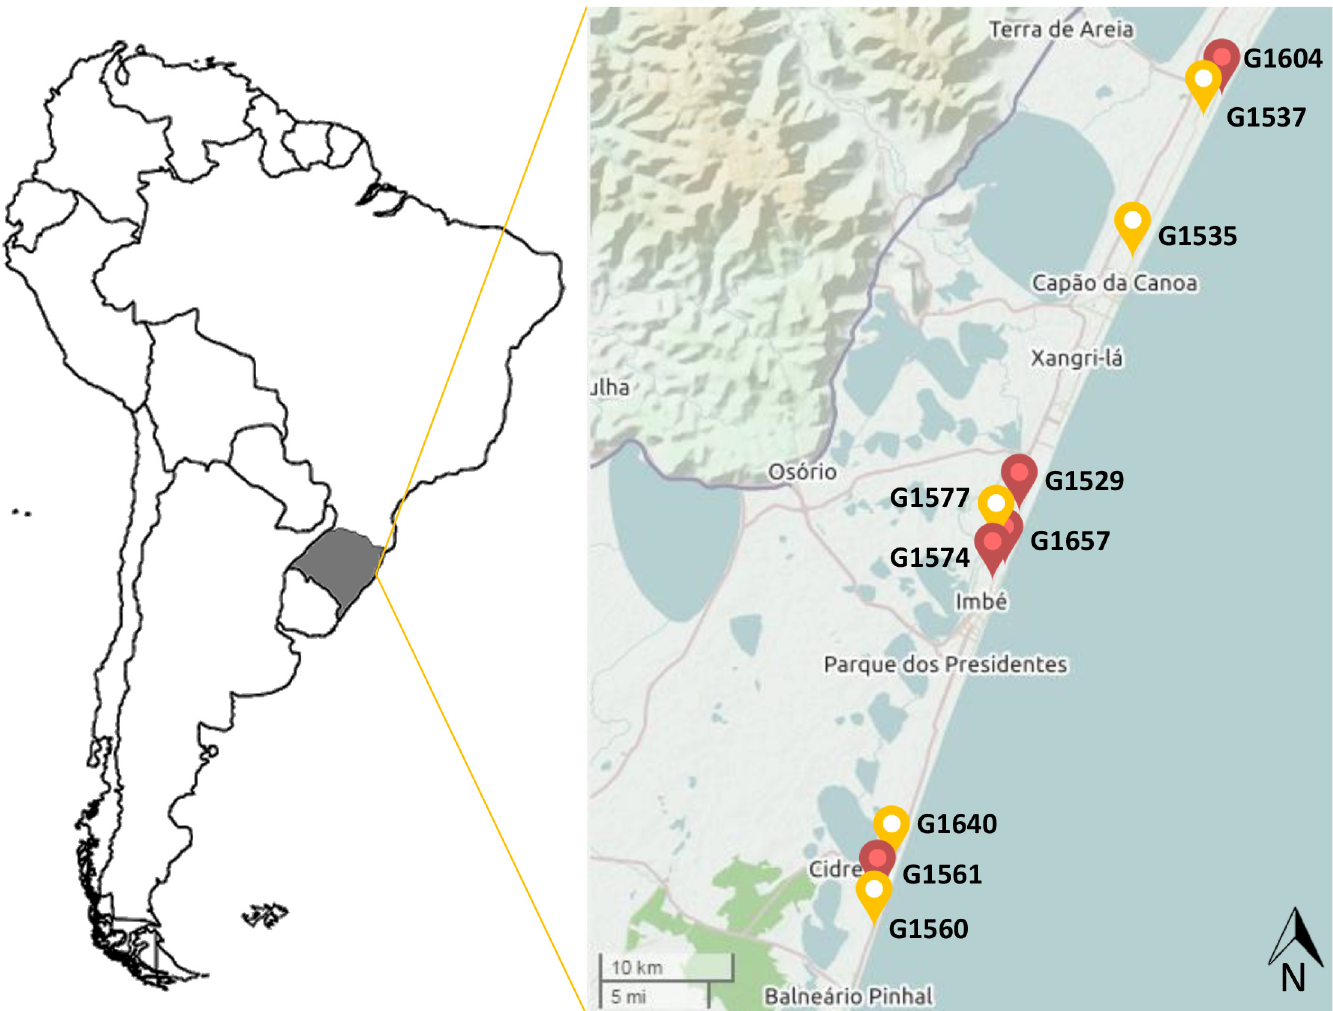
Fig 1. Sample location map. Map indicating the location of where the samples were collected along the coast of the State of Rio Grande do Sul, Brazil (shaded). The map was extracted from the Open Street Map[15]